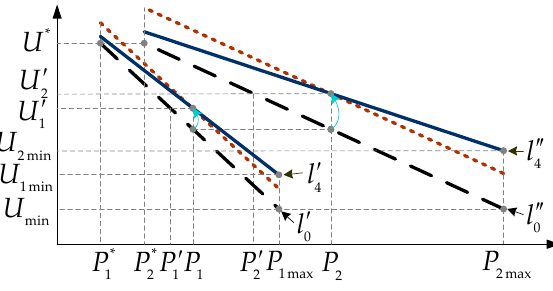
Figure 4. Improved active power sharing of DGs.